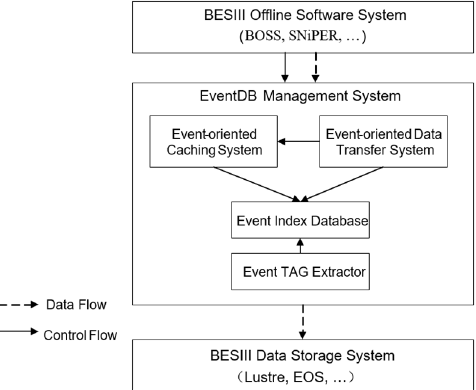
Fig. 1. The architecture of EventDB composed of EventIndexer, EventAccess and EventExtractor